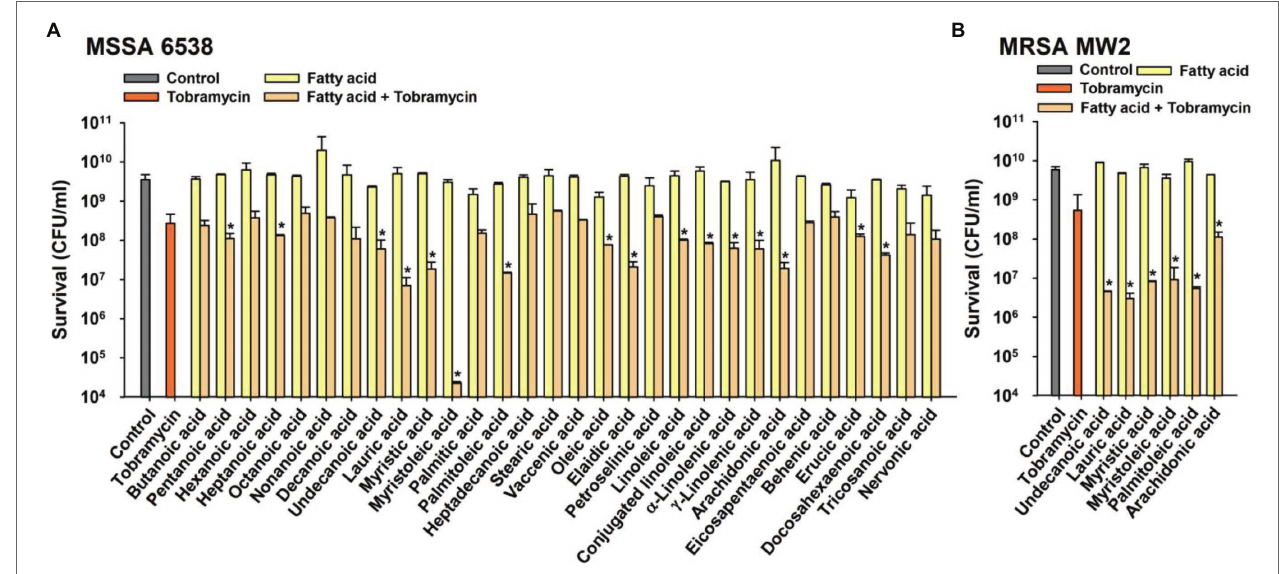
FIGURE 1 | Combinatorial antimicrobial activities of fatty acids and tobramycin against Staphylococcus aureus . Cell survivals were measured after treating MSSA 6538 (A) or MRSA MW2 (B) with tobramycin (10 μ g/ml) and/or a FA (10 μ g/ml) for 1 h. * p < 0.05 vs. tobramycin-treated controls. Control; untreated